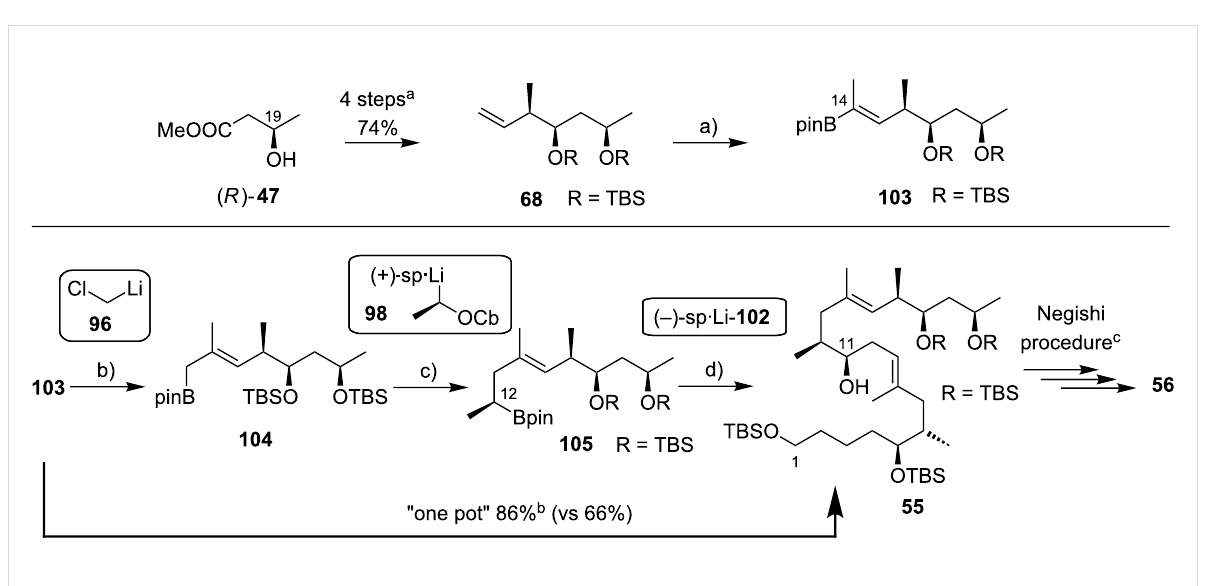
Scheme 11: Aggarwal’s synthesis of the linear C1–C20 fragment of the mycolactone core. Reagents and conditions: a) isopropenylboronic acid pinacol ester, Hoveyda–Grubbs II catalyst (10 mol %, sequentially added), CH 2 Cl 2 , periodic degassing, 60%, Z / E > 99:1; b) ClCH 2 I, n- BuLi , Et 2